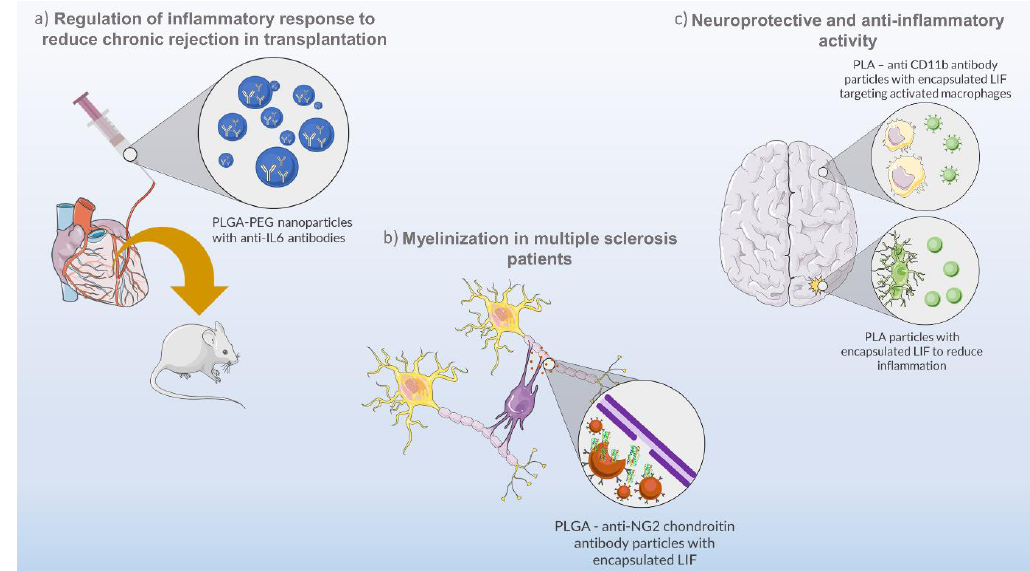
Figure 2. Biotechnological approaches using nanoparticles and cytokines from IL-6 family. ( a ) PLGA (polylactic-coglycolic acid)–PEG (polyethylene glycol) nanoparticles encapsulating anti-IL-6 antibodies for regulation of the inflammatory response in heart transplantation in mice. ( b ) PLGA–anti-NG2 chondroitin antibody particles encapsulating LIF for remyelination of the central nervous system as a therapeutic strategy for multiple sclerosis disease. ( c ) PLA (poly(lactic acid))–anti CD11b